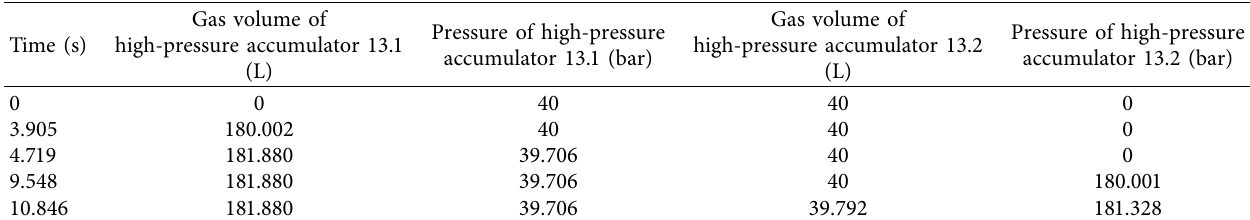
Table 11: Pressure and volume changes in high-pressure accumulators during bite-in and dump-out.